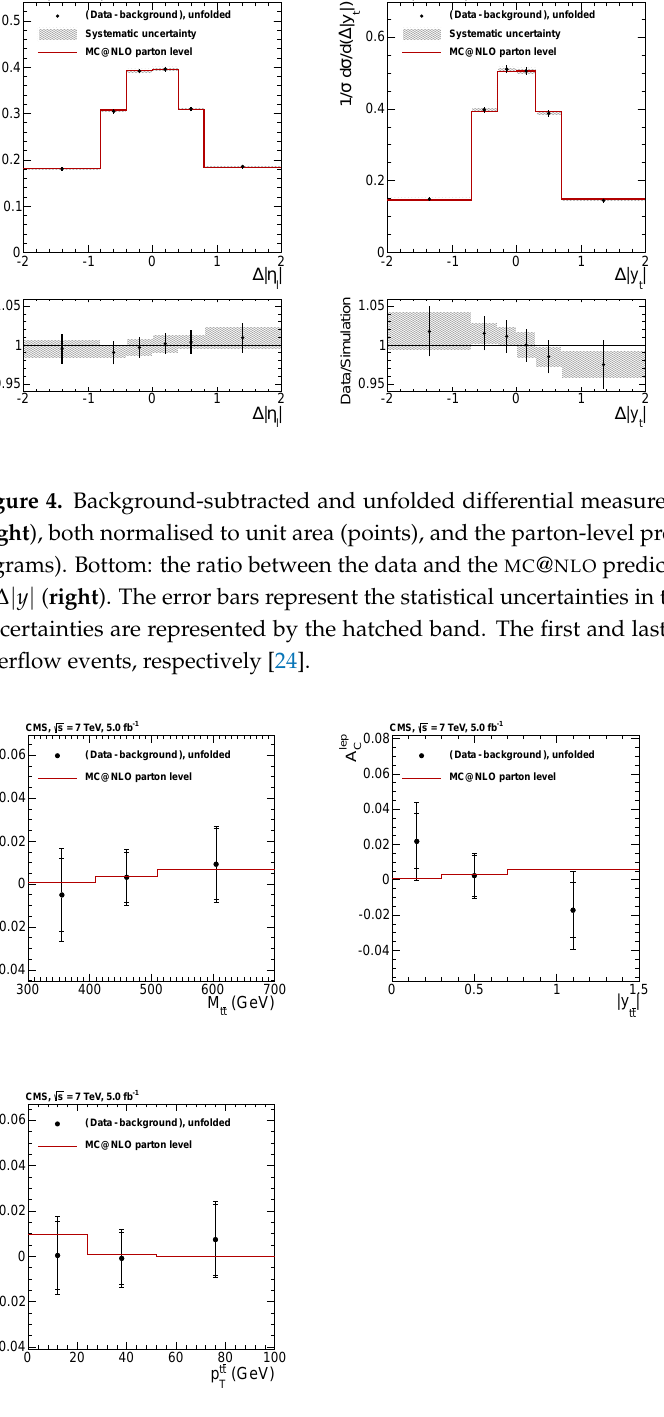
Figure 5. Dependence of the unfolded A (cid:96)(cid:96) ( bottom ), and the parton-level predictions from MC @ NLO (histograms). The inner and outer error bars represent the statistical and total uncertainties, respectively. The last bin of each plot includes overflow events